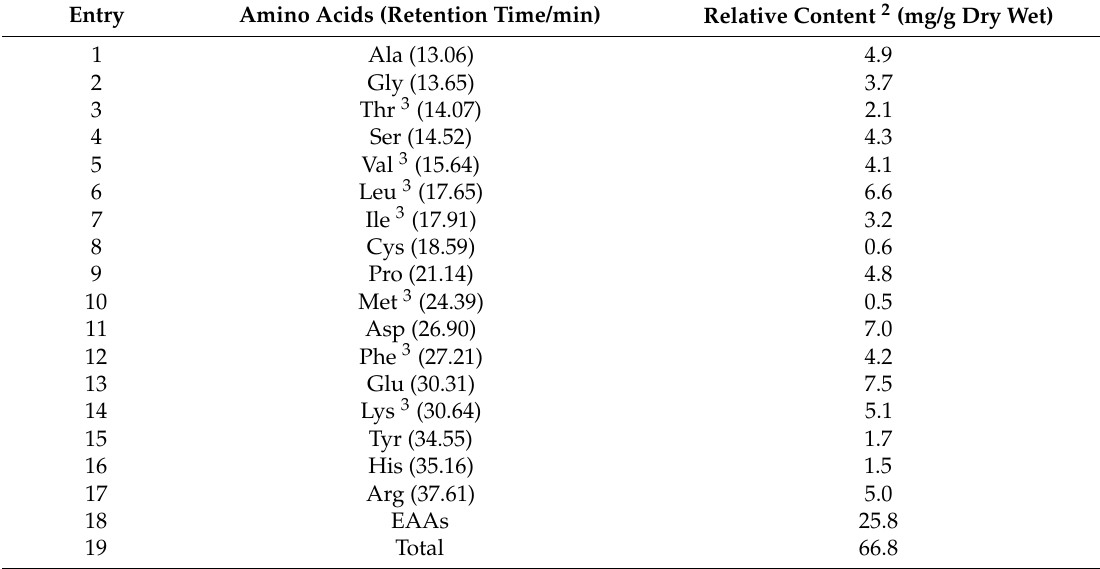
Table 1. aLGN coated SBSE/GC-MS analysis of Camellia Nitidissima Chi seeds (n = 3 1 ).